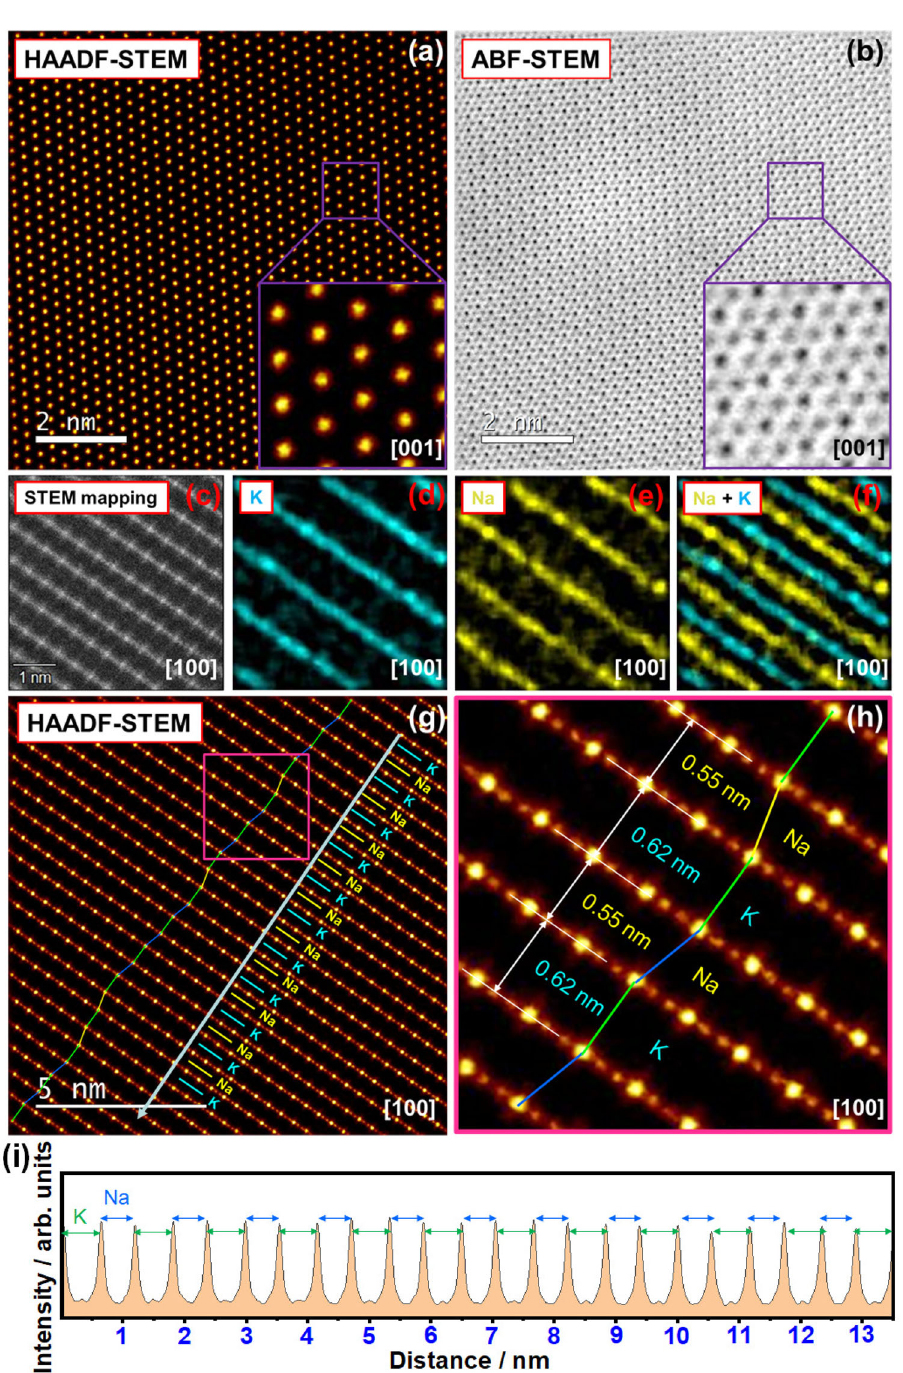
Fig. 2 Arrangement of atoms in NaKNi 2 TeO 6 , viewed along the [001] and [100] directions. a High-angle annular dark- fi eld (HAADF) scanning transmission electron microscopy (STEM) images taken along the [001] zone axis. Overlap of Te and Ni atom positions in the adjacent layers along the c - axis result in spots with uniform intensity (when viewed in the [001] zone axis). b Corresponding annular bright- fi eld (ABF)-STEM image, where also lighter elements (Na, K and O) can be visualised. c HAADF-STEM image of NaKNi 2 TeO 6 taken along the [100] zone axis, revealing bright planes corresponding to the layers comprising Te and Ni, as further explicated in the corresponding energy dispersive X-ray (EDX) imaging (see Supplementary Information (Supplementary Fig. 14) section). d – f STEM-EDX mapping of the area shown in ( a ), where the colours explicitly visualise the distribution of Na and K atoms. The EDX maps show that the layers occupied by Na alternate with those of K. g HAADF-STEM image illustrating the unique stacking sequence in NaKNi 2 TeO 6 . In the layers where K atoms occupy the interlayer space, Te/Ni slabs are not shifted with respect to each other (marked by a green line). However, for layers where Na atoms reside, ±1/3 shifts of the Te/Ni slabs are observed. The yellow and blue lines show shifts in different directions. Note the aperiodicity in the stacking sequence. h Enlarged view of the domain highlighted in ( e ), showing that the interlayer distance is contingent upon the alkali atom species (Na or K) sandwiched between the Te/Ni layers. i Line pro fi le showing alternating interlayer distances occupied by K and Na, as shown by an arrow line in ( g ).